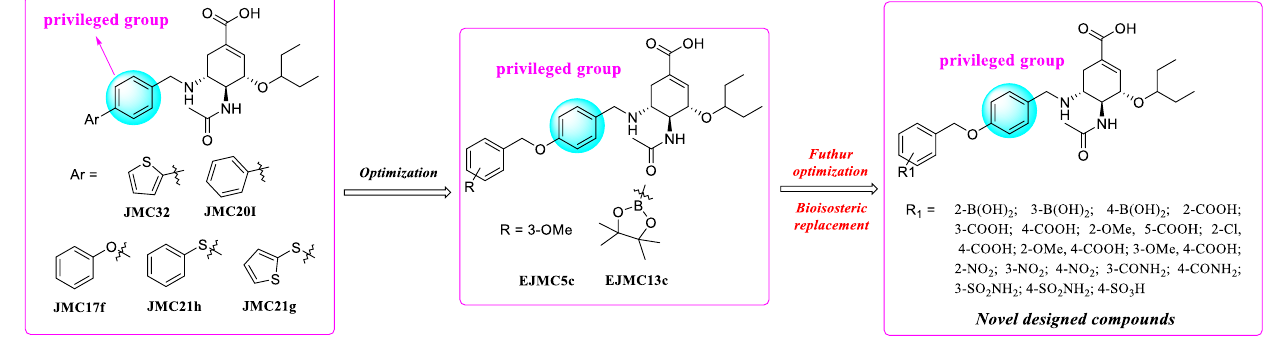
Figure 4. Further optimization of oseltamivir analogues EJMC5c and EJMC13c targeting 150-cavity via bioisosteric replacement